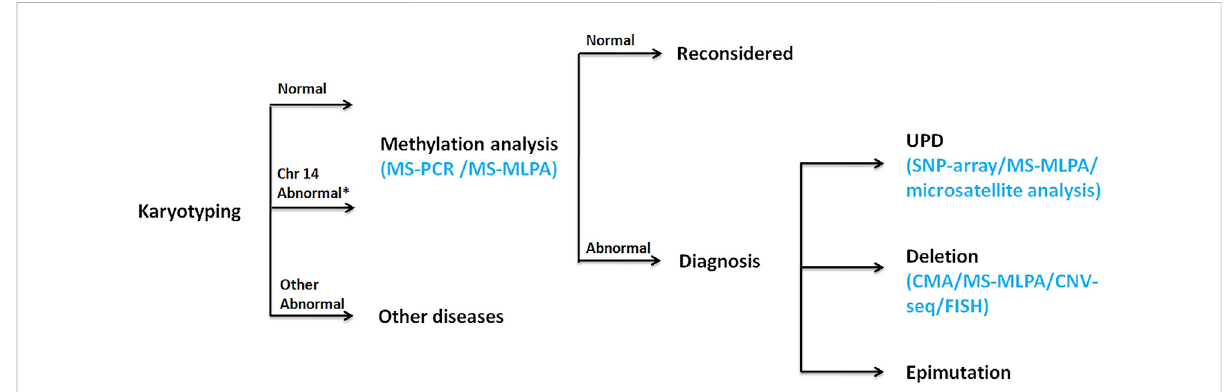
FIGURE 5 Molecular diagnostic fl ow chart. *Chr14 Abnormal: abnormality on chromosome